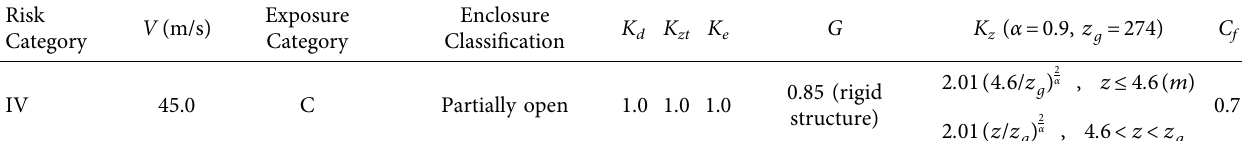
Table 3: Design wind load parameters of the circular shaft and